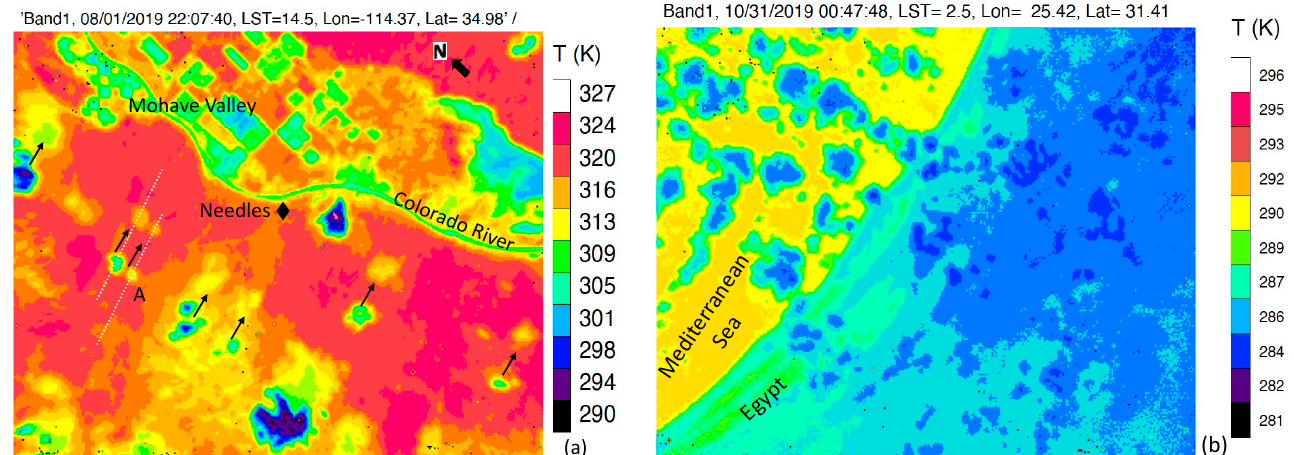
Figure 9. ( a ) Daytime (LST = 14.5 h) PBL clouds over the Mojave Desert near Mohave Village and Colorado River from 1 August 2019; ( b ) nighttime (LST = 2.5 h) PBL clouds near the shore of Egypt and the Mediterranean Sea from 31 October 2019. In the daytime image, cloud shadows are indicated by arrows. The white dotted lines near area “A” indicate the cuts through the cloud-shadow shown in Figure 10.